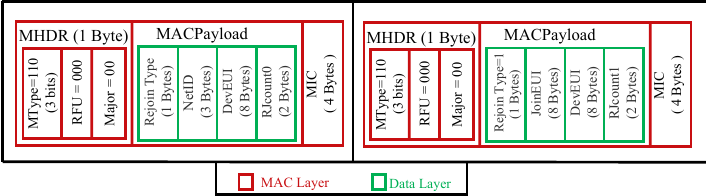
Figure 4. Structures of rejoin-requests types 0, 1, and 2 in LoRaWAN